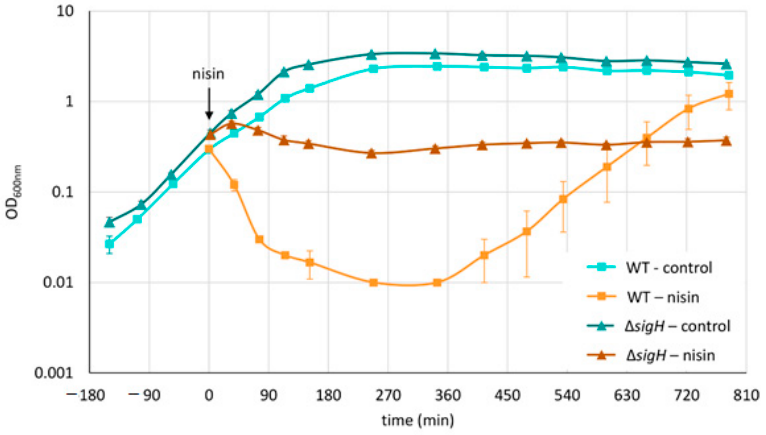
Figure 9. Growth of wild type and sigH mutant strain after treatment with nisin. C. difficile 630 ∆ erm (WT, light colors, squares) and a sigH mutant strain ( Δ sigH , dark colors, triangles) were grown at 37 °C in brain heart infusion (BHI) in an anaerobic chamber. In the exponential growth phase cultures were either treated with nisin (shades of orange) or left untreated (control, shades of blue). Error bars represent standard deviations of the optical densities determined in three biological replicates.